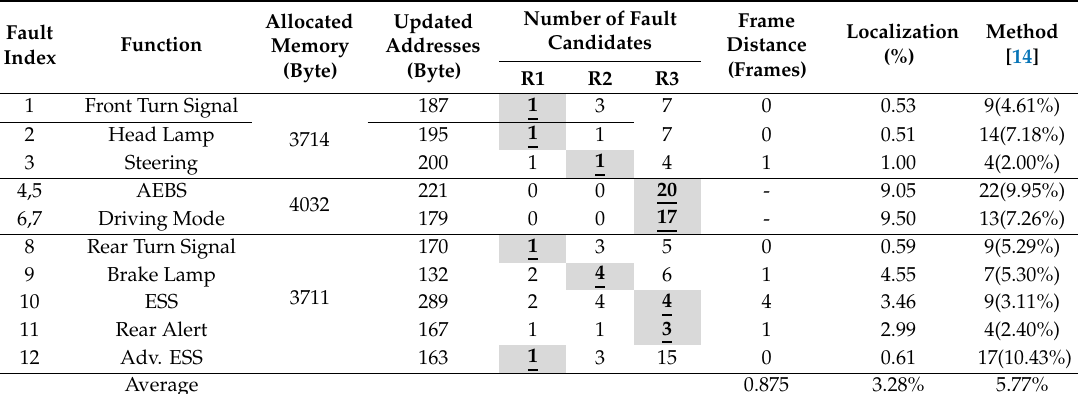
Table 4. Experimental